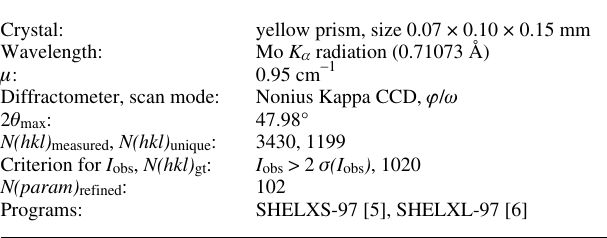
Table 1. Data collection and handling.